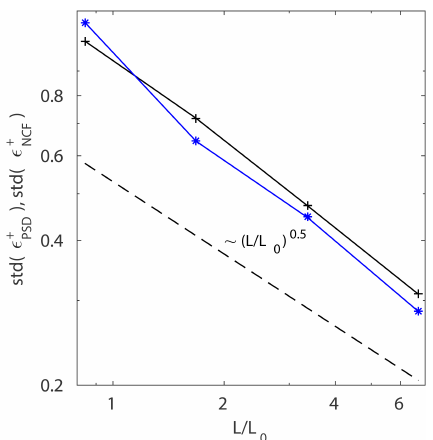
Figure 9. TKE dissipation rate estimates from simulation analy- sis for synthetic signals sampled with 200Hz with u (cid:48) = 0 . 28ms − 1 normalized by the input epsilon (cid:15) = 2 . 5 × 10 − 4 m 2 s − 3 . Black lines with + symbols – (cid:15) NCF , blue lines with ∗ symbols – (cid:15) PSD